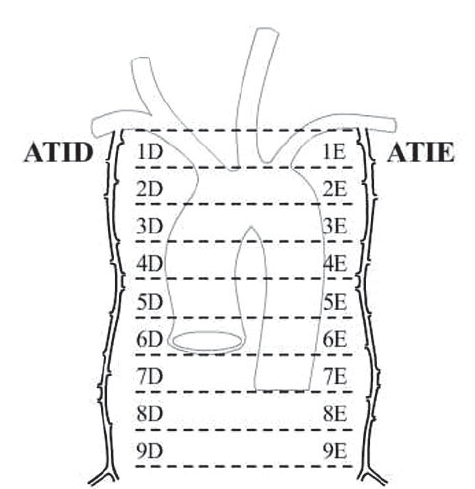
Fig. 1 - O comprimento total das artérias torácicas internas esquerda (ATIE) e direita (ATID), da sua origem até a bifurcação, foi dividido em nove segmentos